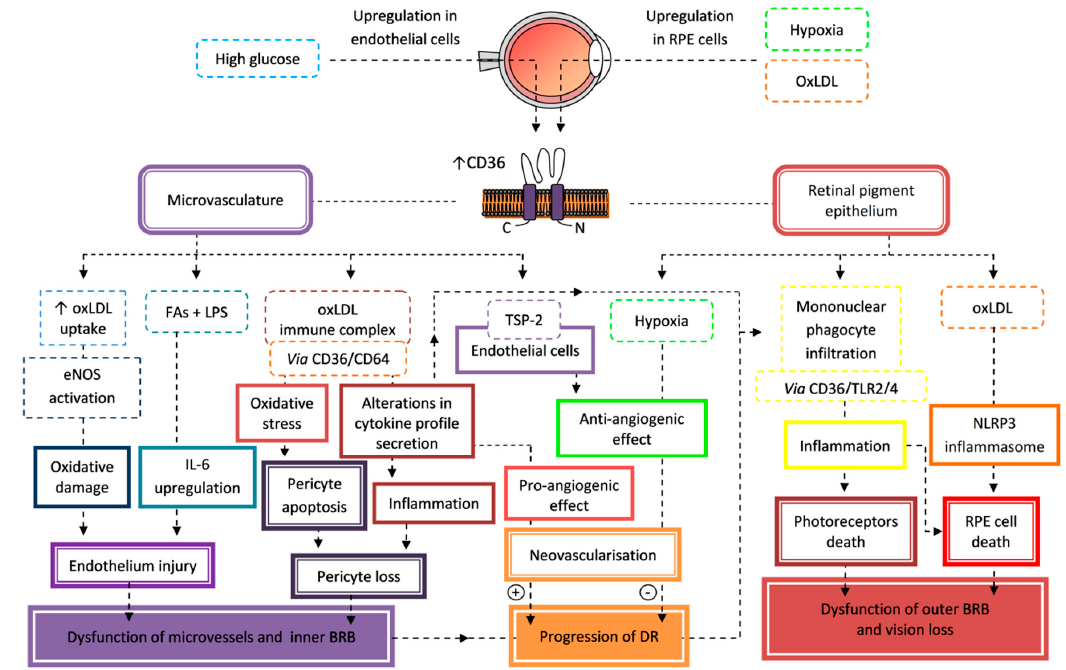
Figure 4. The contribution of CD36 to the pathogenesis of diabetic retinopathy (DR). CD36 is involved in both microvasculature and retinal pigment epithelium (RPE) damage of the retina. Microvascular cell damage is associated with oxidized low-density lipoprotein (oxLDL) uptake and endothelial nitric oxide synthase (eNOS) activation in endothelial cells or the response of pericytes to oxLDL immune complex. The OxLDL immune complex induces pericyte apoptosis, but also inflammation-promoting loss of pericytes and infiltration of the retina by mononuclear phagocytes. Induced dysfunction of the microvessels and inner blood-retina barrier (BRB) intensifies the infiltration of inflammatory cells. Retina inflammation mediated by mononuclear phagocytes or oxLDL also causes photoreceptors and RPE cell death. Moreover, the oxLDL immune complex stimulates the release of proangiogenic cytokine pigment epithelium-derived factor (PEDF), which may favor neovascularization and progression of DR. These events are associated with progressive retina injury and loss of vision. On the other hand, CD36 seems to prevent neovascularization in advanced retinopathy by the interaction of endothelial CD36 with anti-angiogenic thrombospondin (TSP-2) or the anti-angiogenic e ff ect on RPE cells initiated by